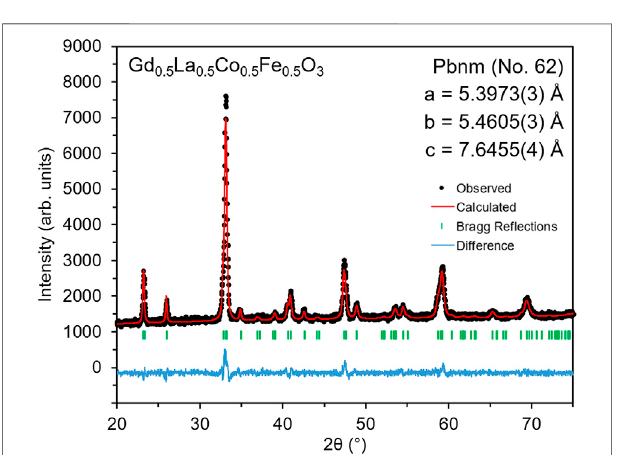
FIGURE 3 | TGA results of the second redox cycle showing redox behaviorofGLCF.Theredcurvecorrespondstothesampletemperature,and the black line corresponds to the extent of reduction ( δ in Gd 0.5 La 0.5 Co 0.5 Fe 0.5 O 3- δ